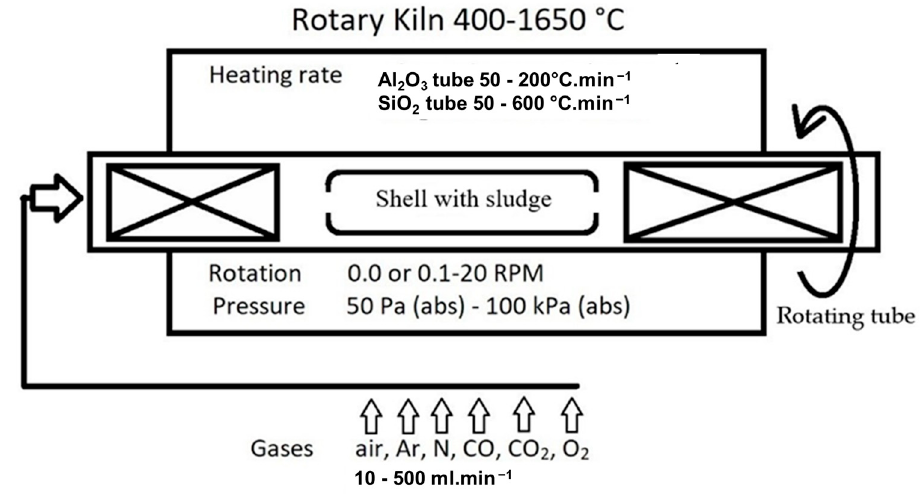
Figure 2. Experimental scheme of technological process in laboratory rotary kiln.